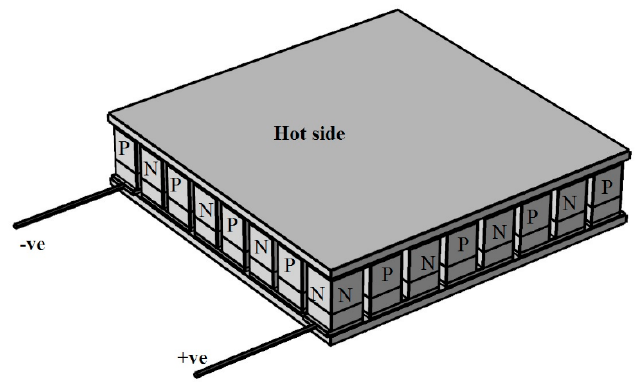
Figure 1. Segmented thermoelectric generator module.